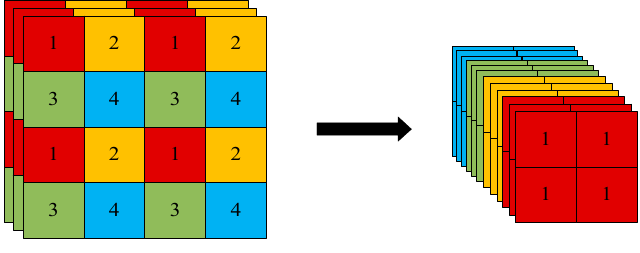
Figure 6. Focus Network Structure.